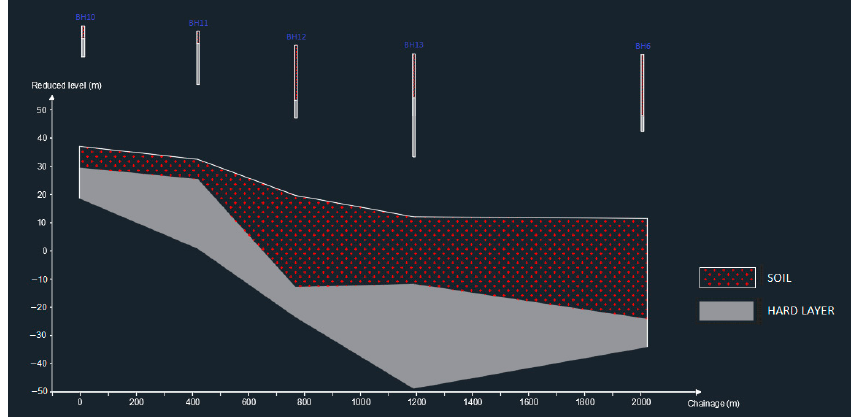
Figure 9. Cross-sectional profile for Case Study 2 based on soil—hard layer/bedrock model.